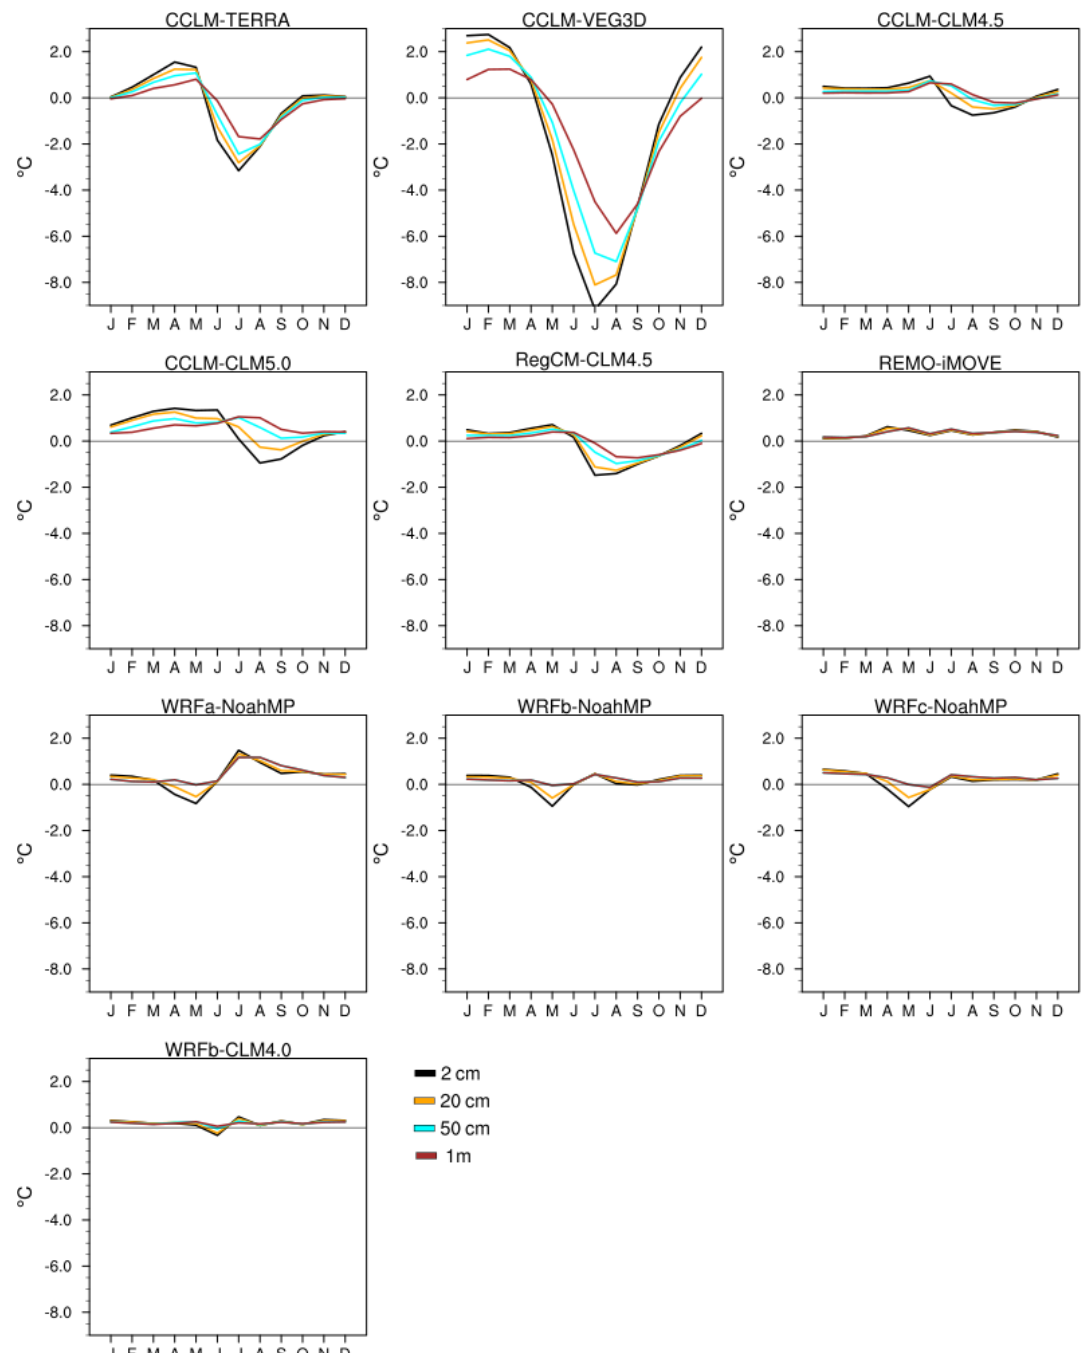
Figure 4. Afforestation impact (FOREST minus GRASS) on mean monthly soil temperature at four different soil depths over Scandinavia.